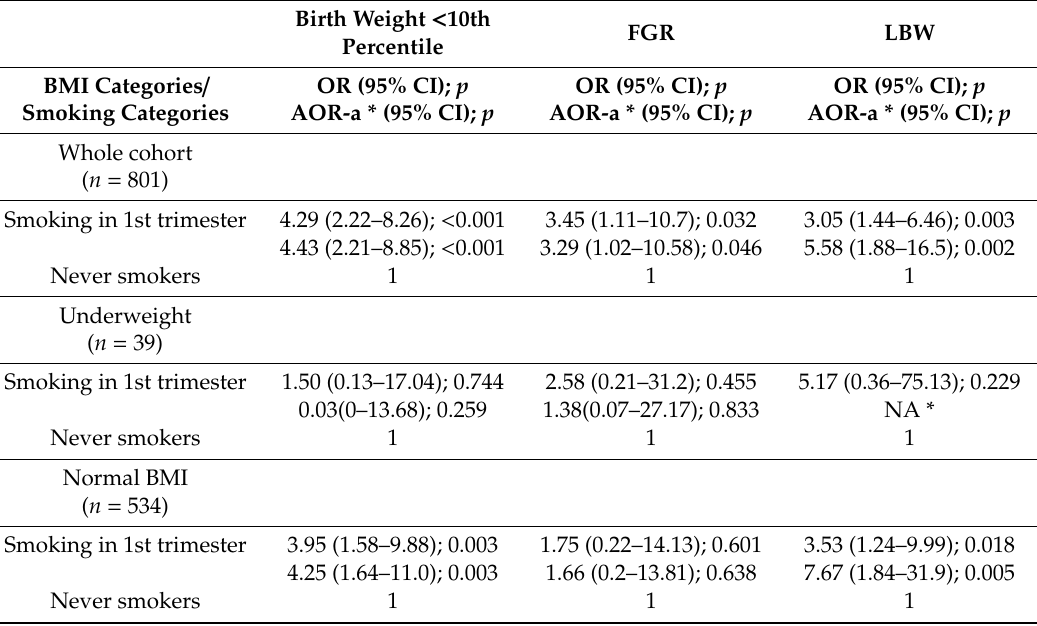
Table 3. The adjusted odds ratios of newborn outcomes for smoking in the 1st trimester, calculated in the subgroups of BMI